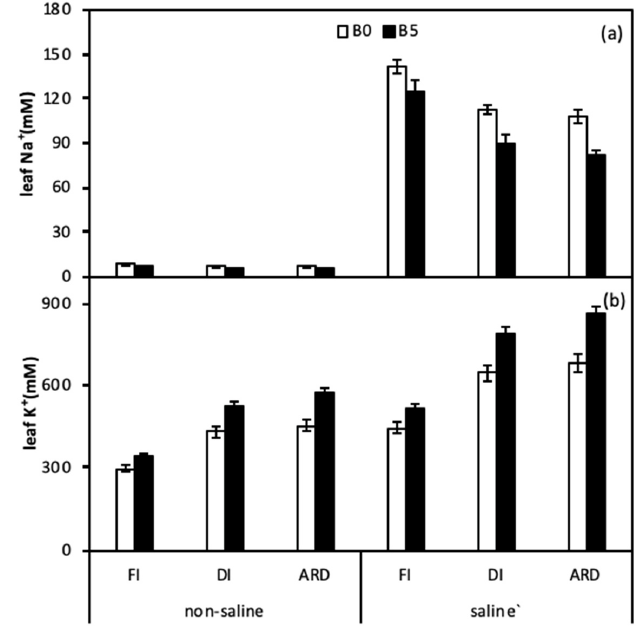
Figure 4. Leaf Na + ( a ) and Leaf K + ( b ) as affected by biochar, irrigation regimes, and salinity. B0 and B5 indicate biochar levels, respectively. FI, DI, and ARD indicate full irrigation, deficit irrigation, and alternate root-zone drying irrigation, respectively. Error bars indicate ± SE ( n = 4). SE indicates standard error.